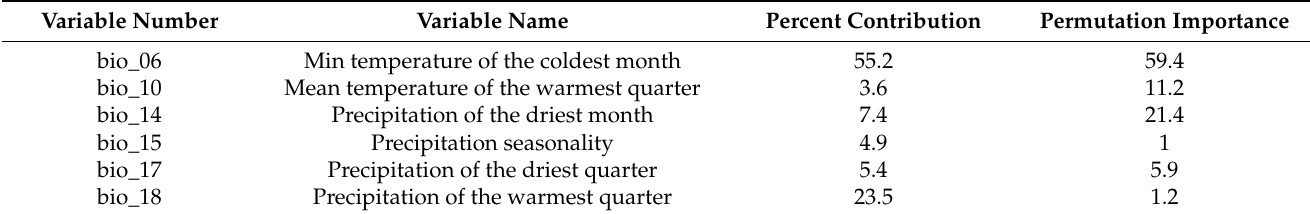
Figure 3. ROC curve and AUC values for current MaxEnt model. ROC: receiver operating characteristic. AUC: the area under the receiver operating characteristic curve. Table 1. Estimates of relative contributions of the environmental variables to the MaxEnt